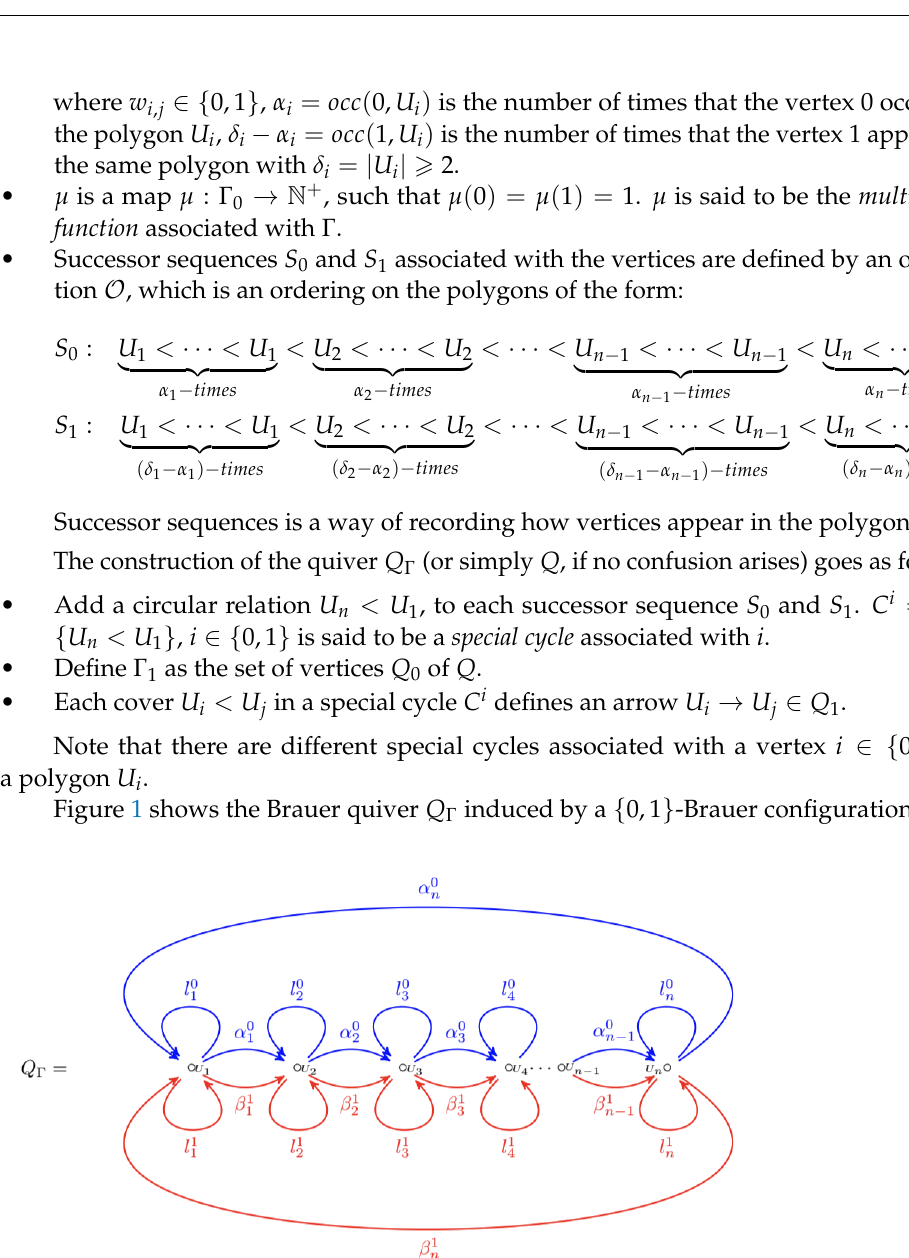
, i ∈ { 0,1 } , j = occ ( i , U ) − 1 j j